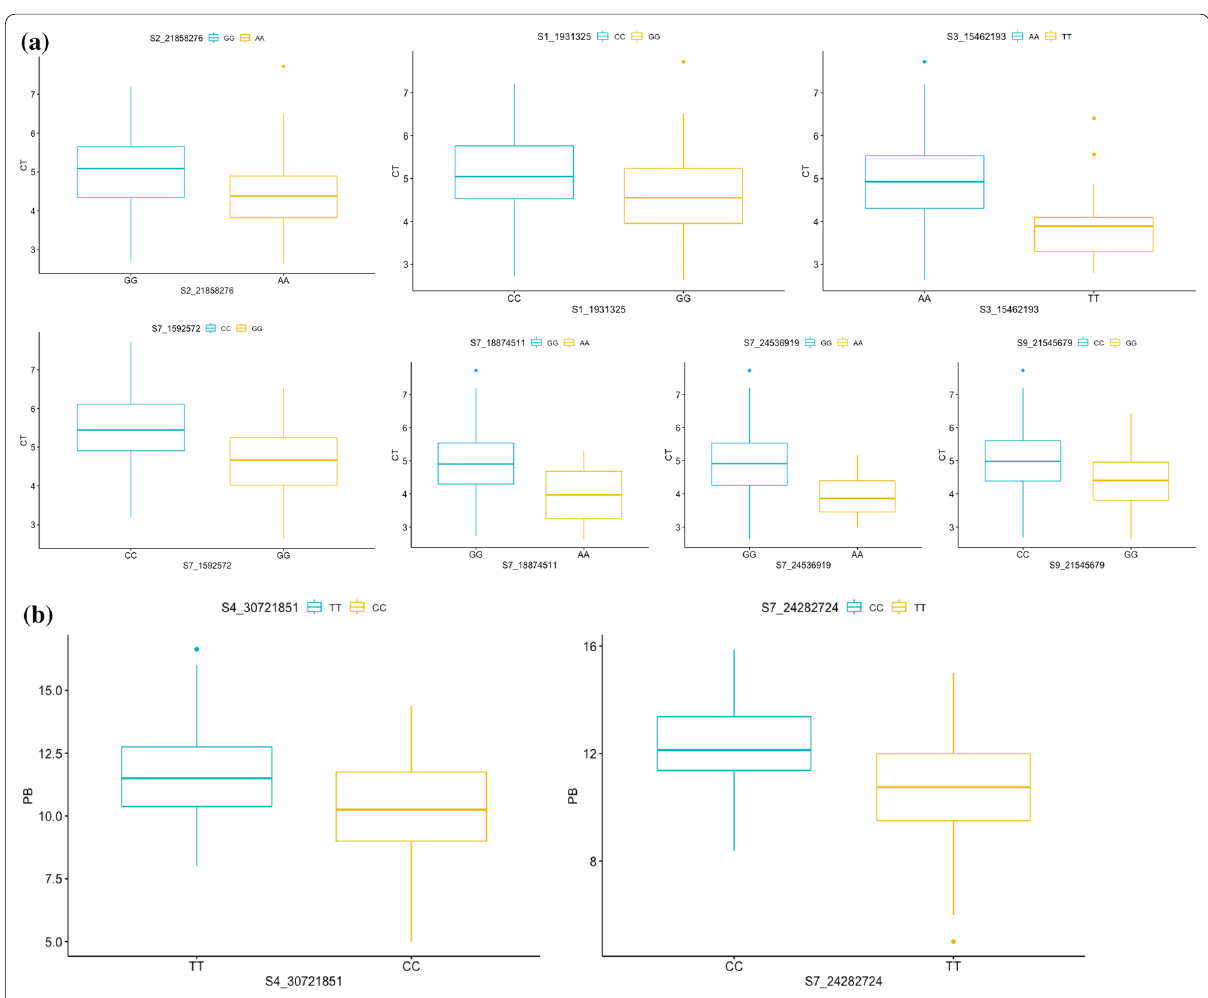
Fig. 6 Box and whisker plots depicting significant allelic effects of significant MTAs for all the traits a CT b PB c PL d GL e GW f